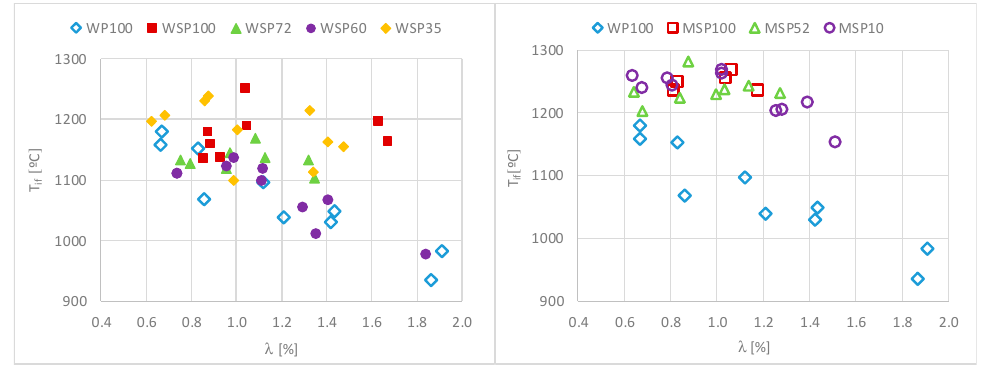
Figure 5. T if temperature vs. λ . Comparison between the WP100 and WSP family ( left ) and the MSP family ( right ).